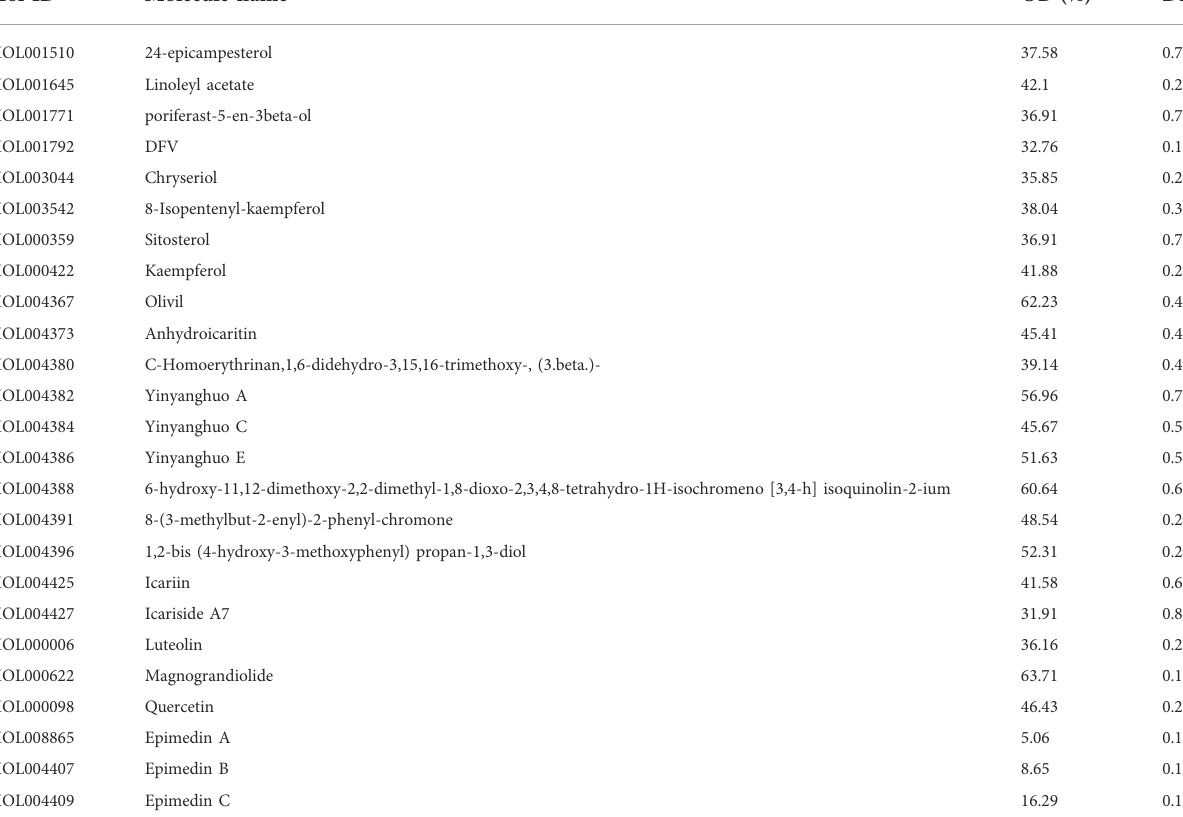
TABLE 1 Candidate active components of Epimedii Folium. Mol ID Molecule